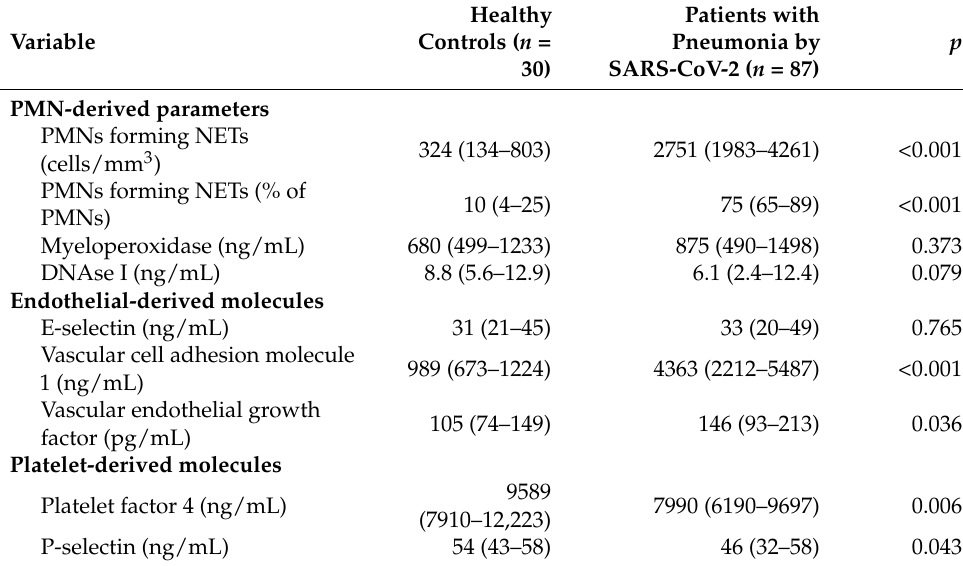
Table 2. PMNs-related parameters, and endothelial- and platelet-derived variables in control and patients at